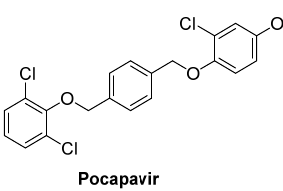
Figure 1. Chemical structure of the capsid binder